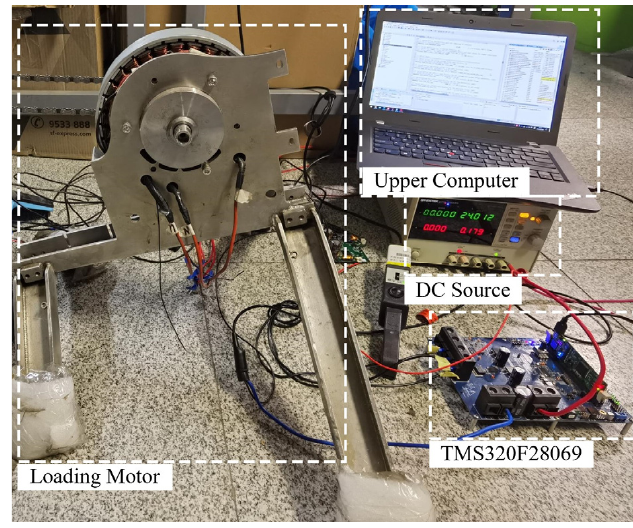
Figure 8. The experimental platform.